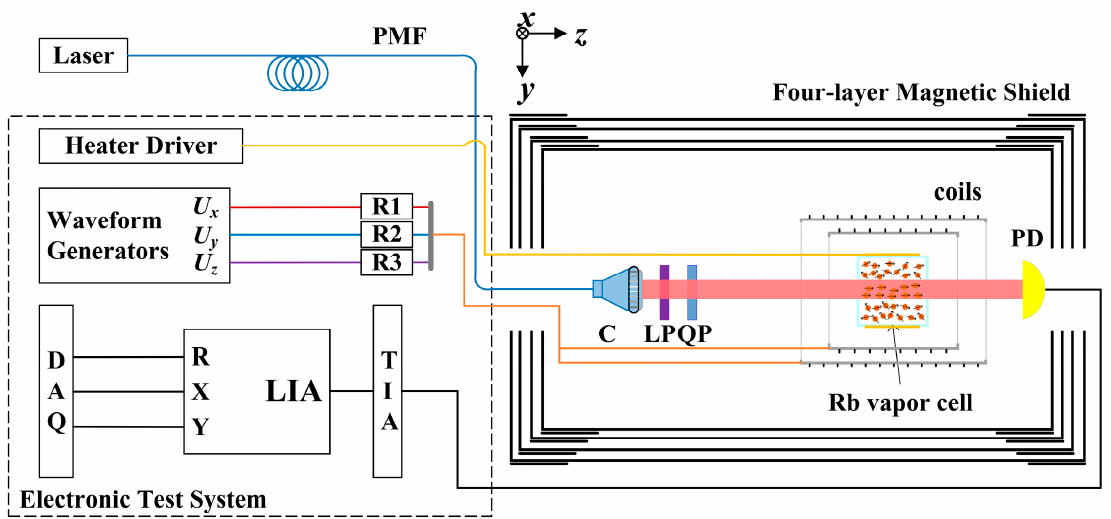
Figure 2. Experimental setup. PMF: polarization maintaining fiber; C: collimating lens; LP: linear polarizer; QP: quarter-wave plate; PD: photodiode; TIA: transimpedance amplifier; LIA: lock-in amplifiers; DAQ: data-acquisition; R1, R2, and R3: resistors.